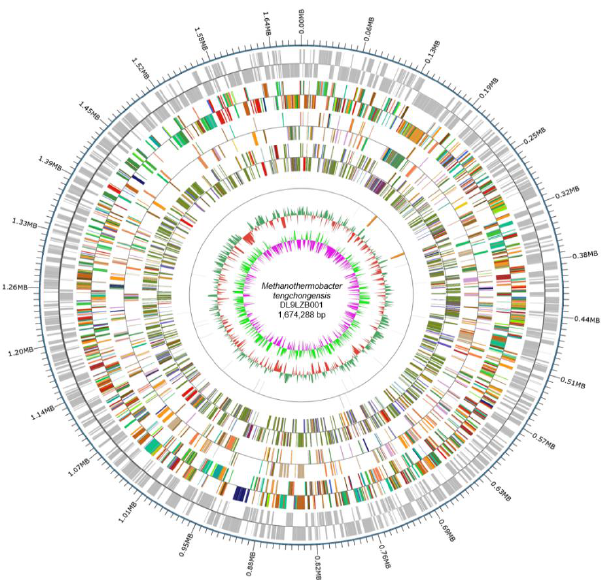
Figure 4. The entire genome map of M. tengchongensis DL9LZB001. The outermost circle is the posi- tion of the genome sequence. From the outside to the inside: coding genes, gene function annotation results, ncRNA, genome GC contents, and genome GC skew values. We calculated the GC contents and GC skew values based on window bp (chromosome length/1000) and step bp (chromosome length/1000). The red inward part indicates that the GC content in that area is lower than the average of the entire genome, while the green outward part shows higher GC content. The heights of the peaks indicate the difference in value between the GC content of that area and the average GC con- tent. The algorithm of the skew value is (G – C)/(G + C), and the pink inward part indicates that the content of G in that area is lower than that of C, while for the light green outward part the reverse applies. The heights of the peaks indicate the value difference. Table 2. General genome features of M. tengchongensis DL9LZB001. General Features